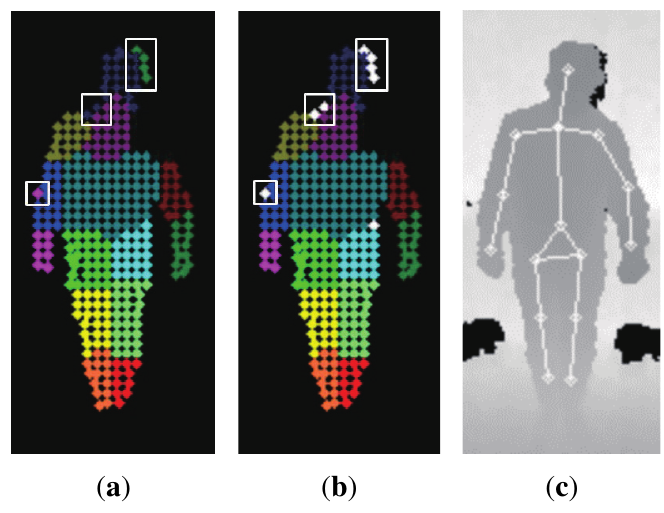
Figure 3. An example of: ( a ) superpixel classification; ( b ) optimization; ( c ) pose estimation. Misclassified superpixels removed in the optimization process are indicated by white rectangles.